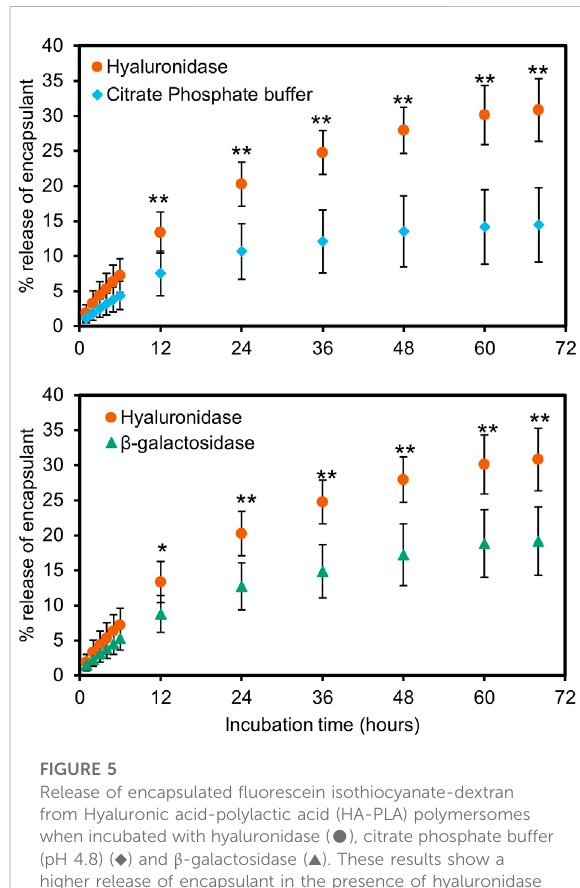
FIGURE 5 Release of encapsulated fl uorescein isothiocyanate-dextran from Hyaluronic acid-polylactic acid (HA-PLA) polymersomes when incubated with hyaluronidase ( C ), citrate phosphate buffer (pH 4.8) ( ◆ ) and β -galactosidase ( ▲ ). These results show a higher release of encapsulant in the presence of hyaluronidase compared to buffer without enzyme (top) or in β -galactosidase, a non-cognate enzyme (bottom). ( n = 4, * = p < 0.05, ** = p <